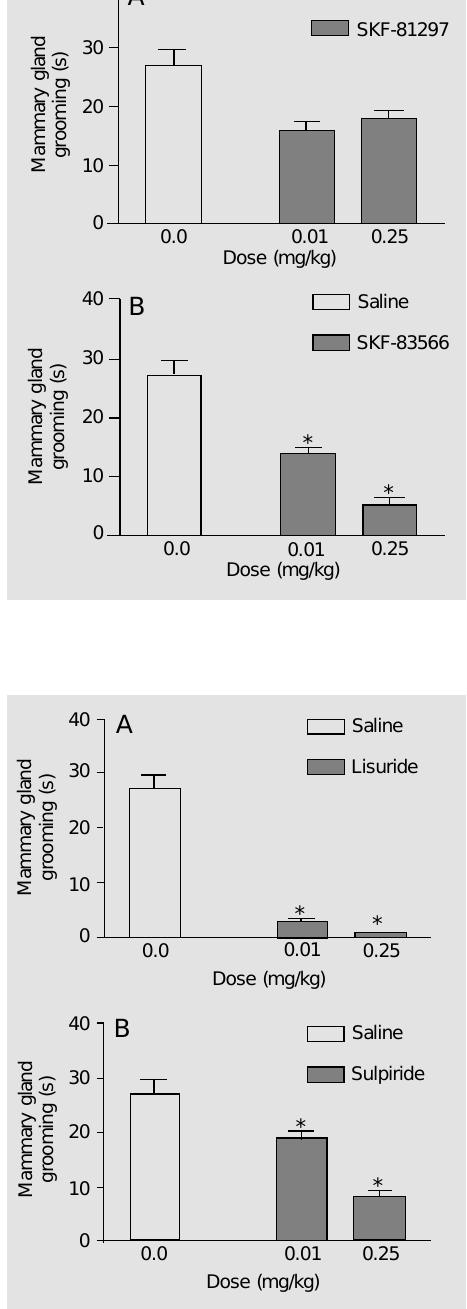
Figure 1. Effects of acute sc treatment with the D1-like re- ceptor agonist SKF-81297 (A) and antagonist SKF-83566 (B) on the duration of self-grooming of